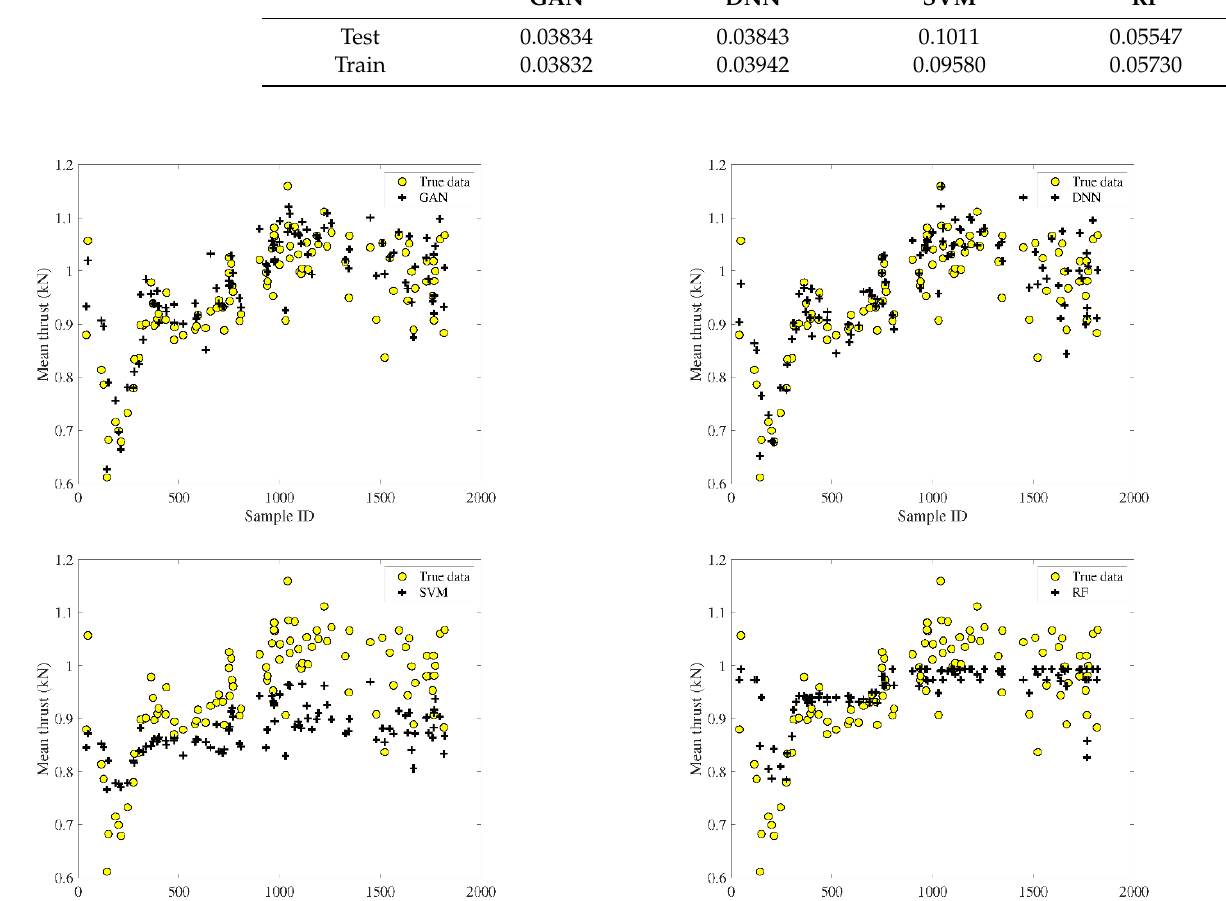
Figure 8. Comparison of the mean thrust prediction of the PMLM models built by proposed GAN and baseline methods.